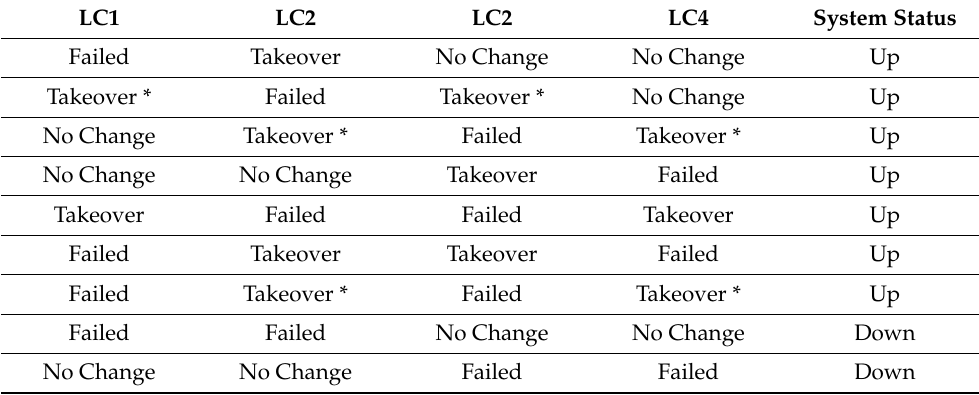
Figure 19. System parameters under failure of two local controllers. Table 2. The take-over chart during fail-over